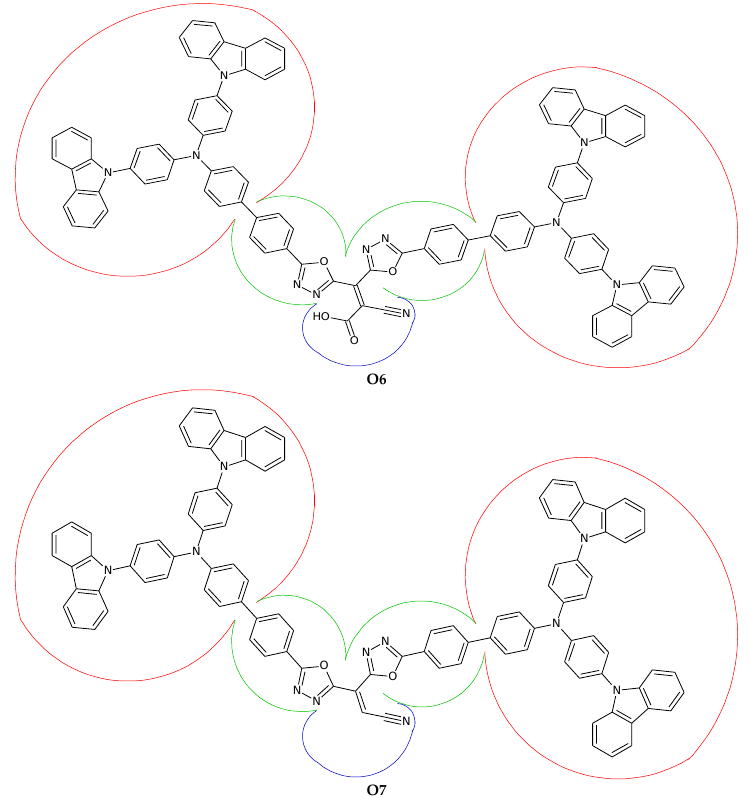
Figure 2. 1,3,4-oxadiazoles containing compounds that were evaluated for metal-free organic dyes through TD-DFT